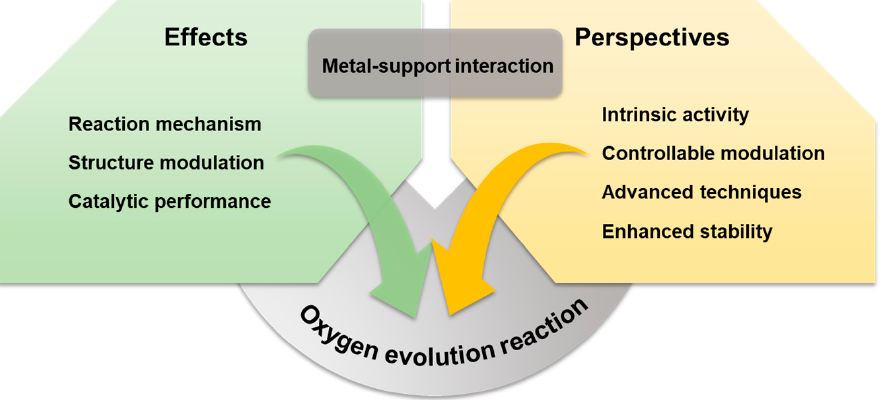
Figure 12. Schematic diagrams of MSI effects and perspectives on catalyst design and preparation for OER.